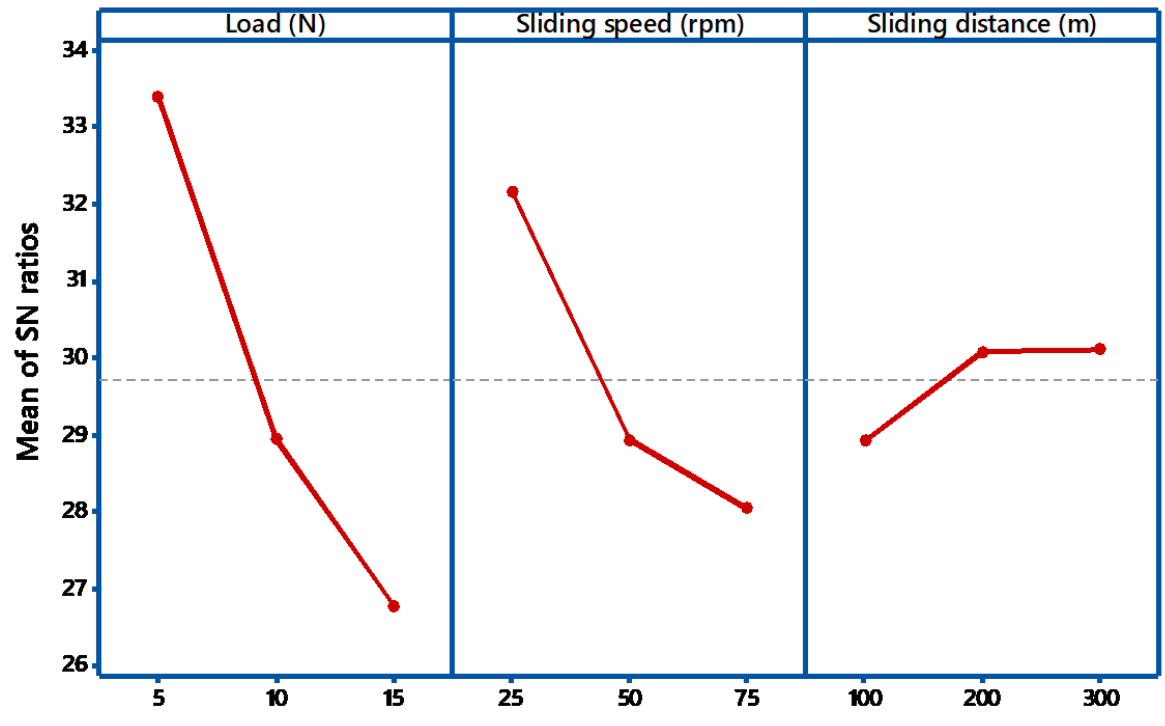
Figure 3. Main effect plot (S/N ratio).